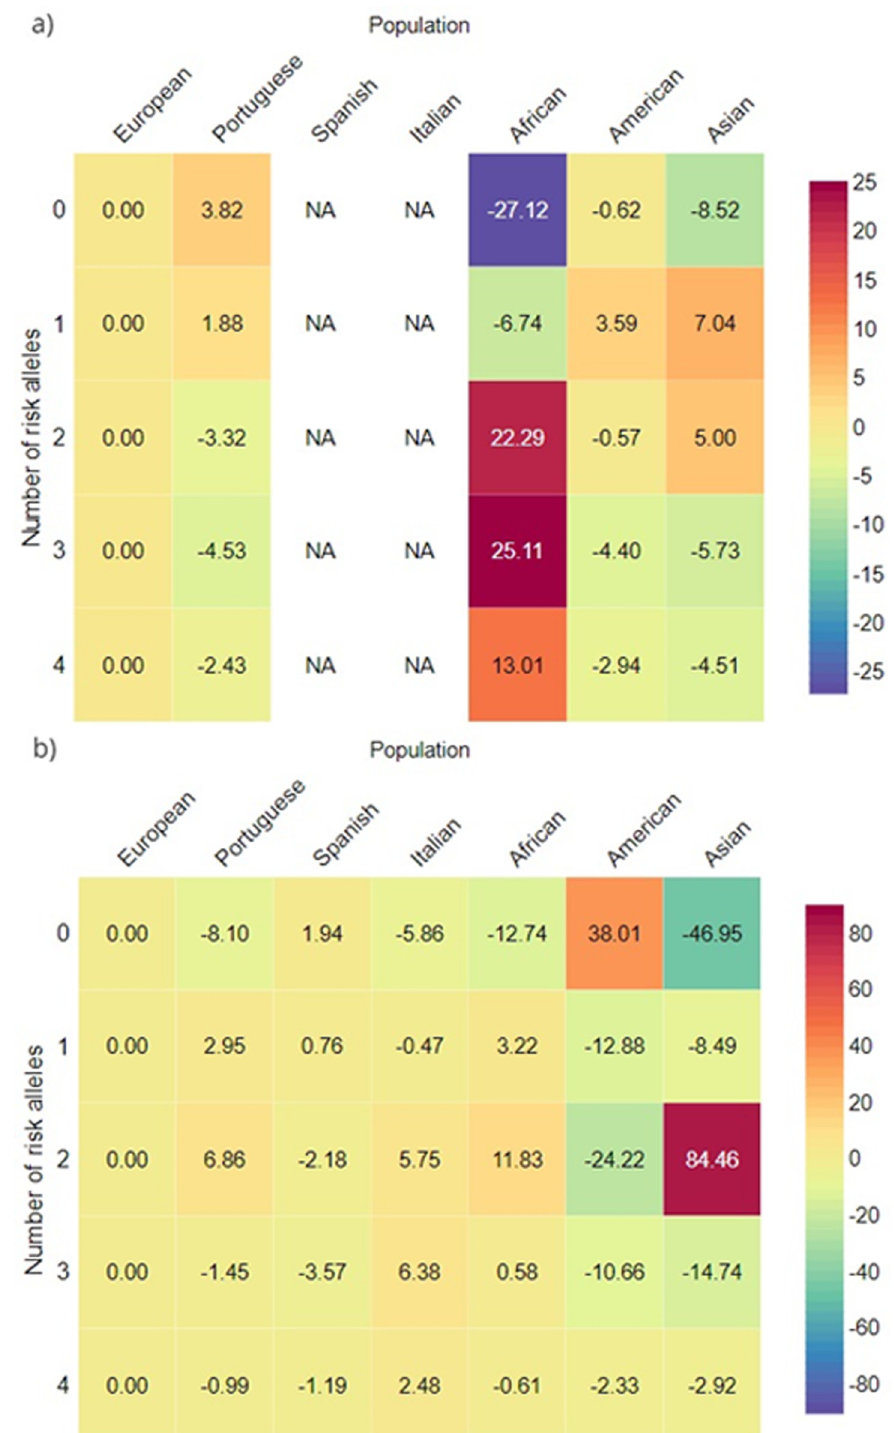
Fig 6. Adjusted residues heatmap for a) bi-allelic risk of COVID-19 infection susceptibility and b) bi-allelic risk of severe COVID-19 with respiratory failure. Red colour means that the target population/risk level is overrepresented, comparatively to the European distribution; Purple colour means that the target population/risk level is underrepresented, comparatively to the European distribution. NA—No data available.